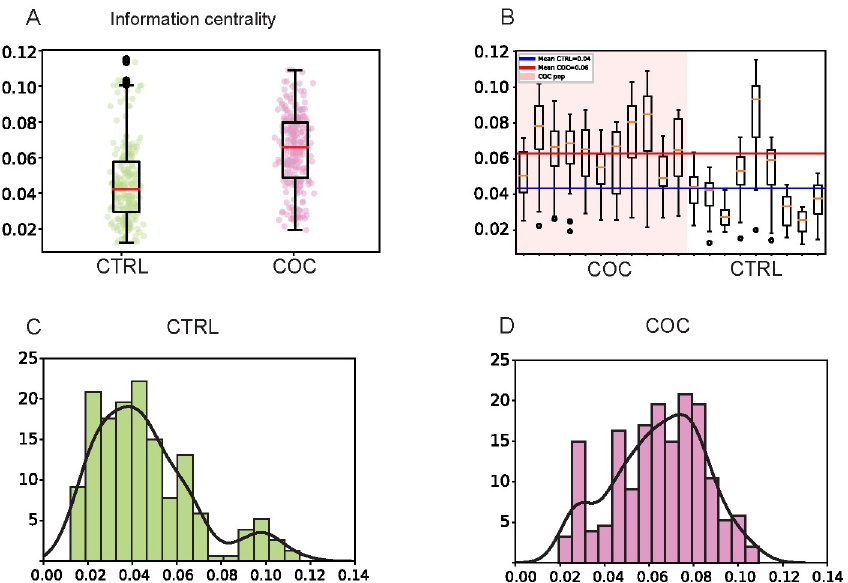
Fig 4. Differences between CTRL and COC SINs in degree centrality, closeness centrality, and clustering coefficient. A), D), G) Box plot of median values for nine CTRL SINs (n = 270 flies) grouped on the regular food and eleven COC SINs (n = 330) grouped and orally administrated to 0.50 mg/mL of cocaine for 24 hours before tracking in degree centrality A), closeness centrality D) and clustering coefficient G). Data are extracted from 10 minute videos using FlyTracker and analyzed using NetworkX. Statistical analysis was performed using independent-samples t -tests with Welch-correction since group sizes are different. p- values less than 0.05 are taken as significant and presented in S1 Table. B), E), H) Graphical illustration of local-level SINs from the isolated CTRL group using an open-source software Gephi for visualization and editing of the visual appearance of a given network. Nodes are represented with size and color proportional to the values of their centrality measures. Nodes with higher values of centrality measure degree centrality B), closeness centrality E) and clustering coefficient H) are shown as bigger and darker. C), F), I) Graphical illustration of local-level SINs from the isolated COC group using an open-source software Gephi for visualization and editing of the visual appearance of a given network. Nodes are depicted with the size and color proportional to the values of their centrality measures. Nodes with higher values of centrality measure degree centrality C), closeness centrality F) and clustering coefficient I) are shown as bigger and